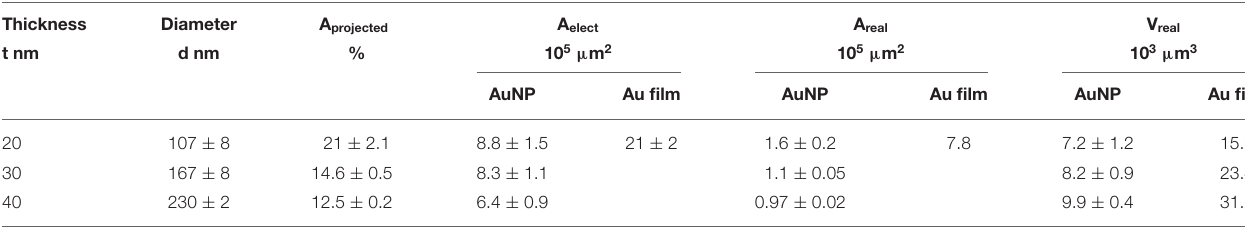
TABLE 1 | Comparative electrode areas and volumes developed by AuNP@ITO and Au-film@ITO electrodes considering electrochemical, projected, or real Au surfaces and volumes developed on the total sample (S = 0.0078 cm 2 ). Thickness Diameter A projected A elect A real V real t nm d